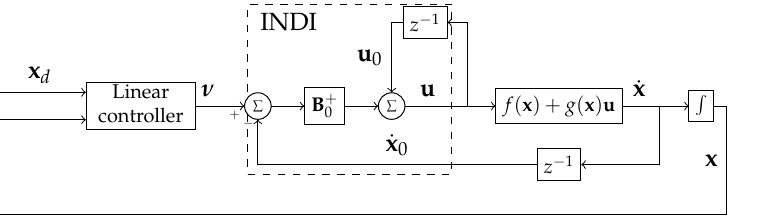
Figure 7. INDI closed loop block